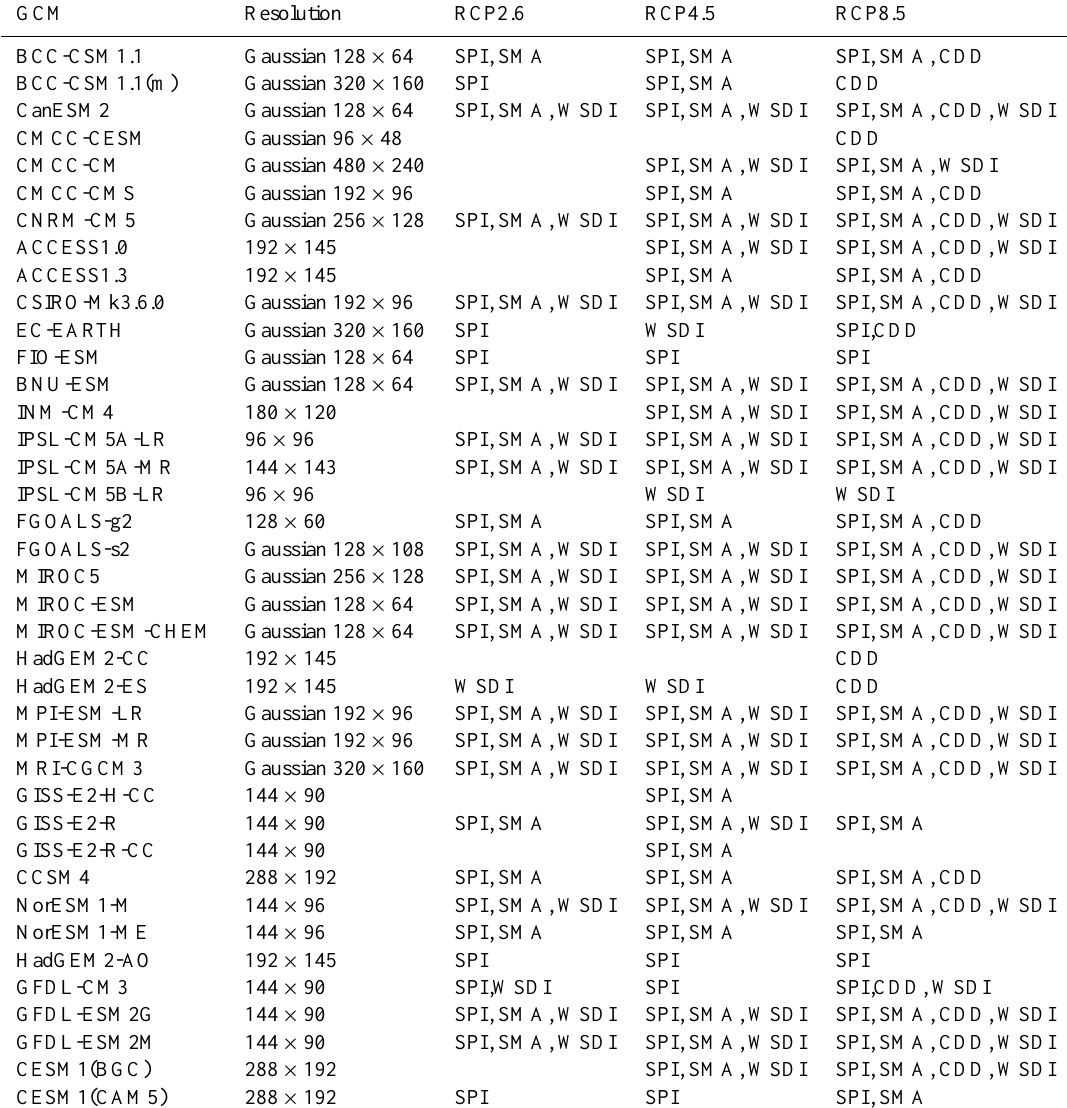
Table 1. GCMs from the CMIP5 used in our study. Columns give GCM name, horizontal resolution and for each future GHG concentrations scenario the drought and heat wave indices that could be calculated from each GCM. SPI: Standardised Precipitation Index; SMA: Soil Moisture Anomalies; CDD: Consecutive Dry Days; WSDI: Warm Spell Duration Index. See Sect. 2 and the